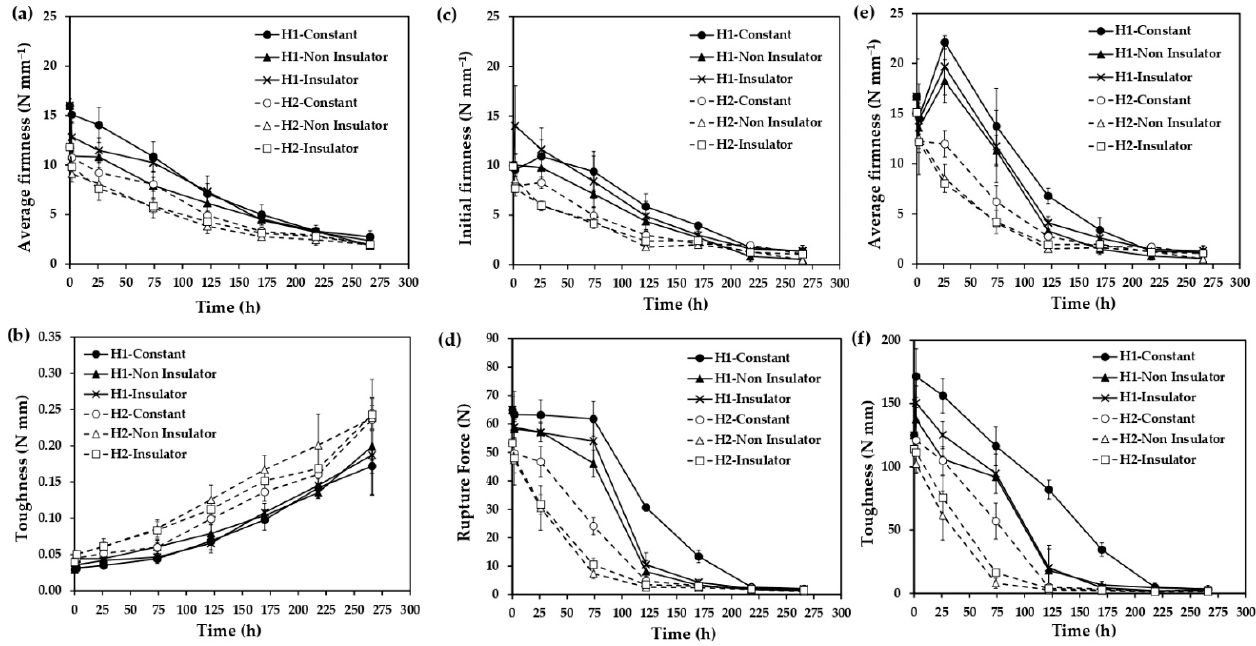
Figure 4. ( a ) Non-destructive—average firmness; ( b ) non-destructive—toughness; ( c ) destructive— initial firmness; ( d ) destructive—rupture force; ( e ) destructive—average firmness; and ( f ) destructive—toughness of mango fruit (‘Nam Dok Mai Si Thong’) under constant, non-insulated, and insulated conditions during simulated handling at the tarmac. After simulated handling at the tarmac, mango fruits from the first and second harvest were transferred to a temperature of 20 °C for 266 h. H1, first harvest; H2, second harvest. Vertical bars on the graph indicate S.D. ( n = 3).